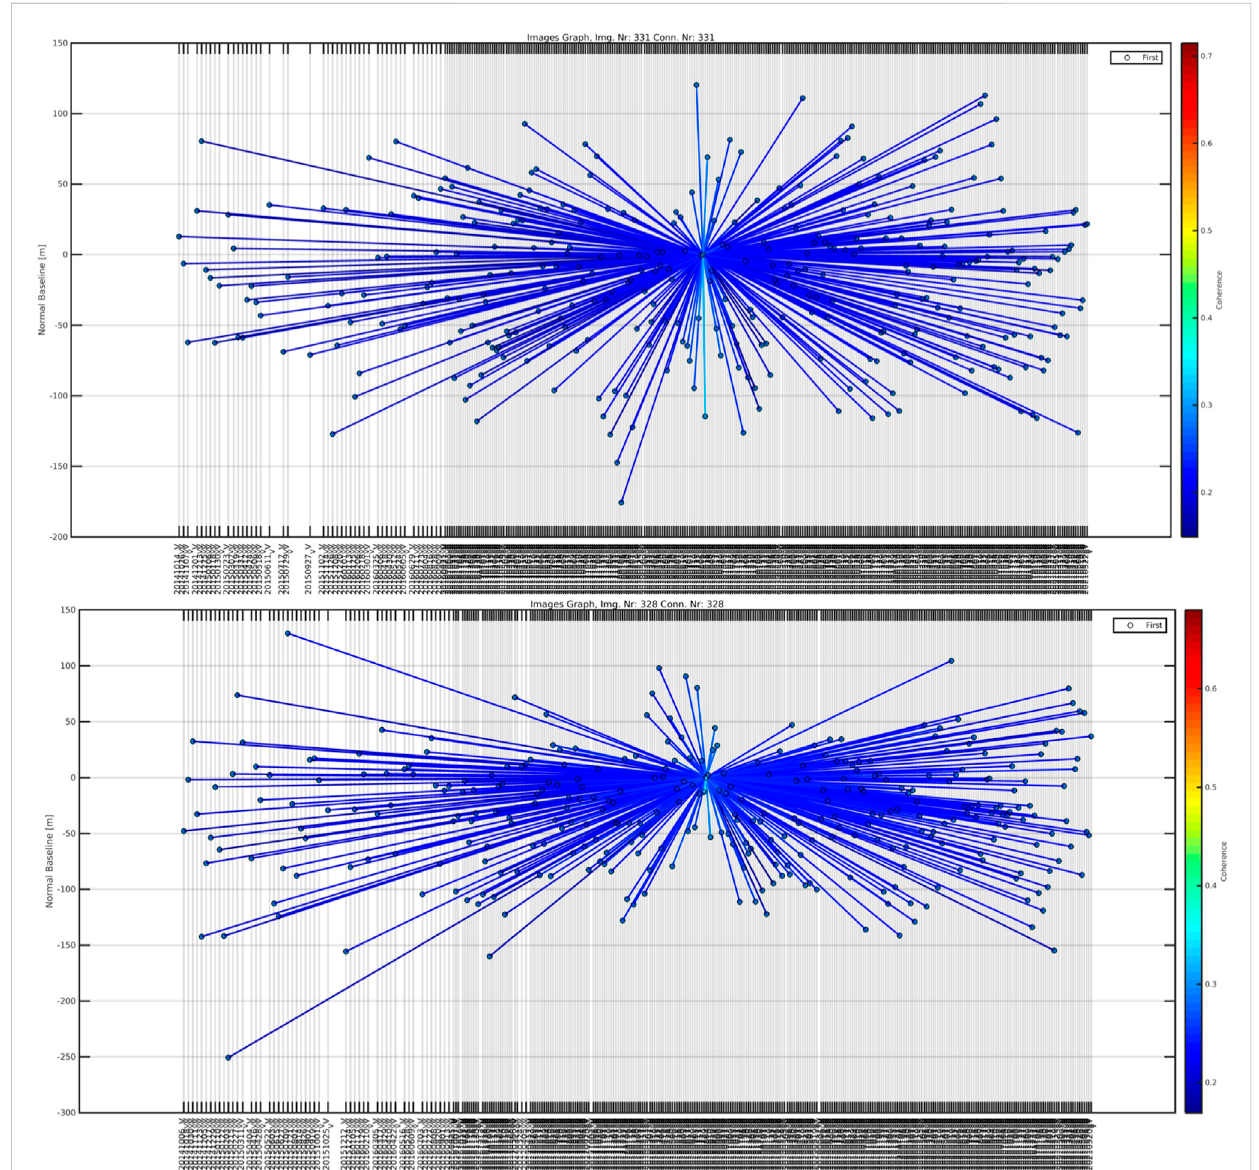
FIGURE 4 Distribution of normal (vertical axis) and temporal (horizontal axis) baselines for Ascending Track 131 (top) and Descending Track 7 (bottom).